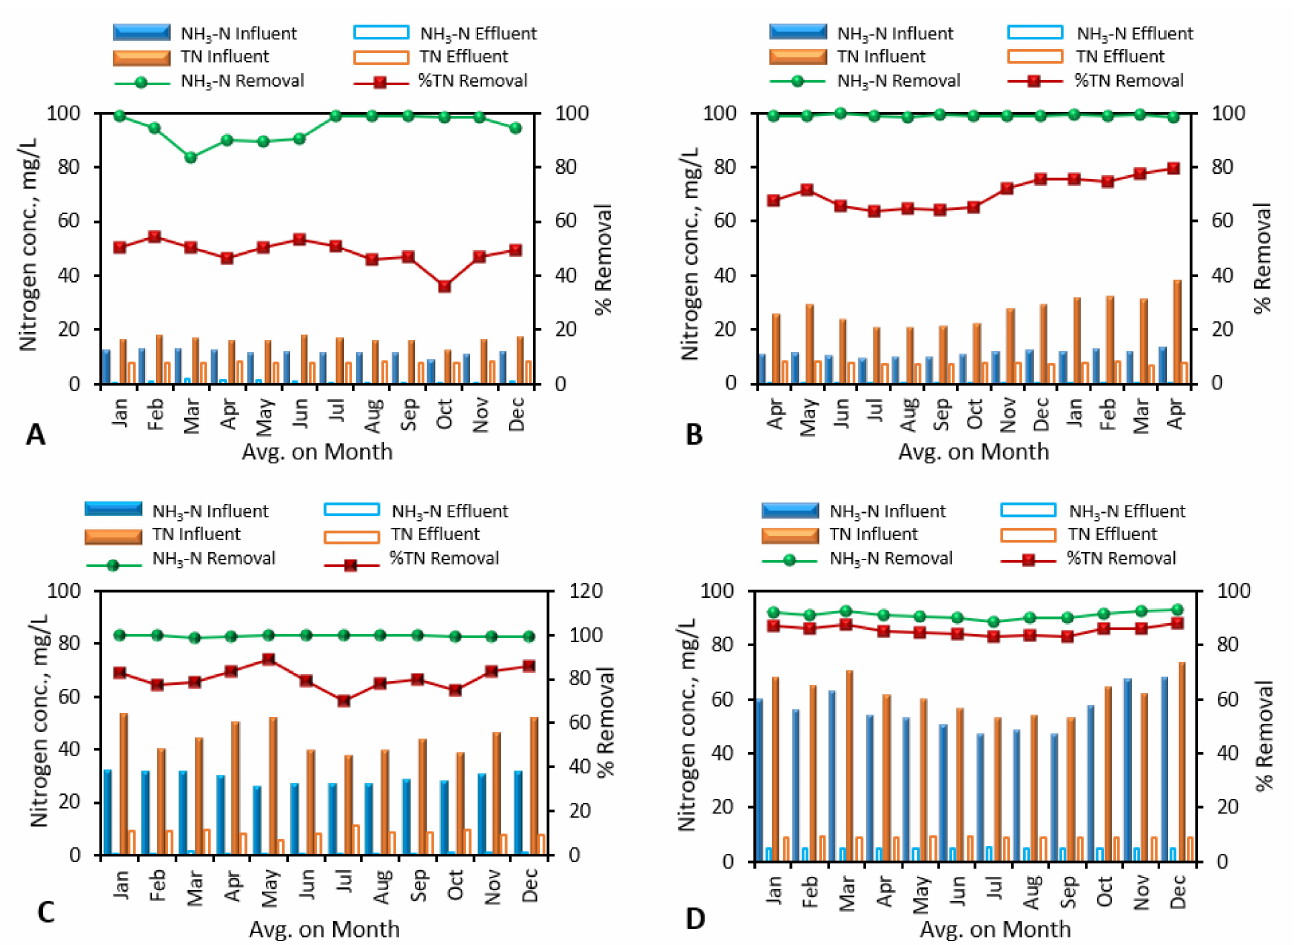
Figure 2. Nitrogen performance with low COD:TN ratio at ( A ) L1 and ( B ) L2, and high COD:TN ratio at ( C ) H1 and ( D )